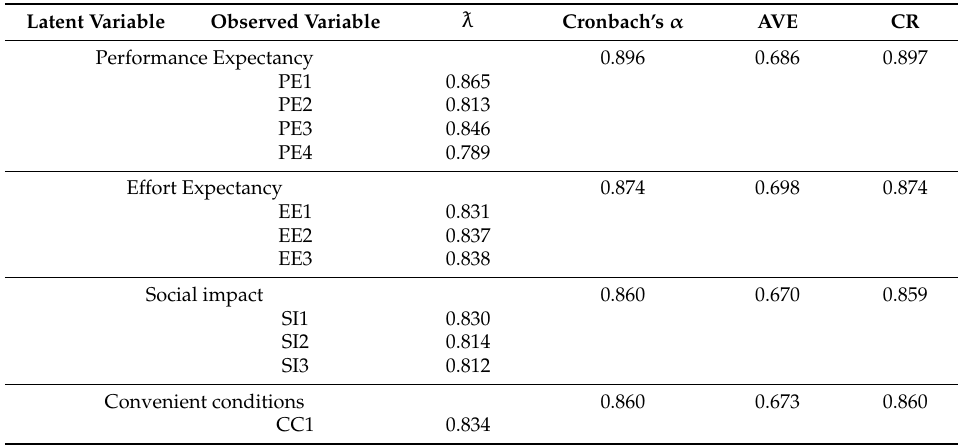
Table 4. The outcomes of a confirmative factor analysis.